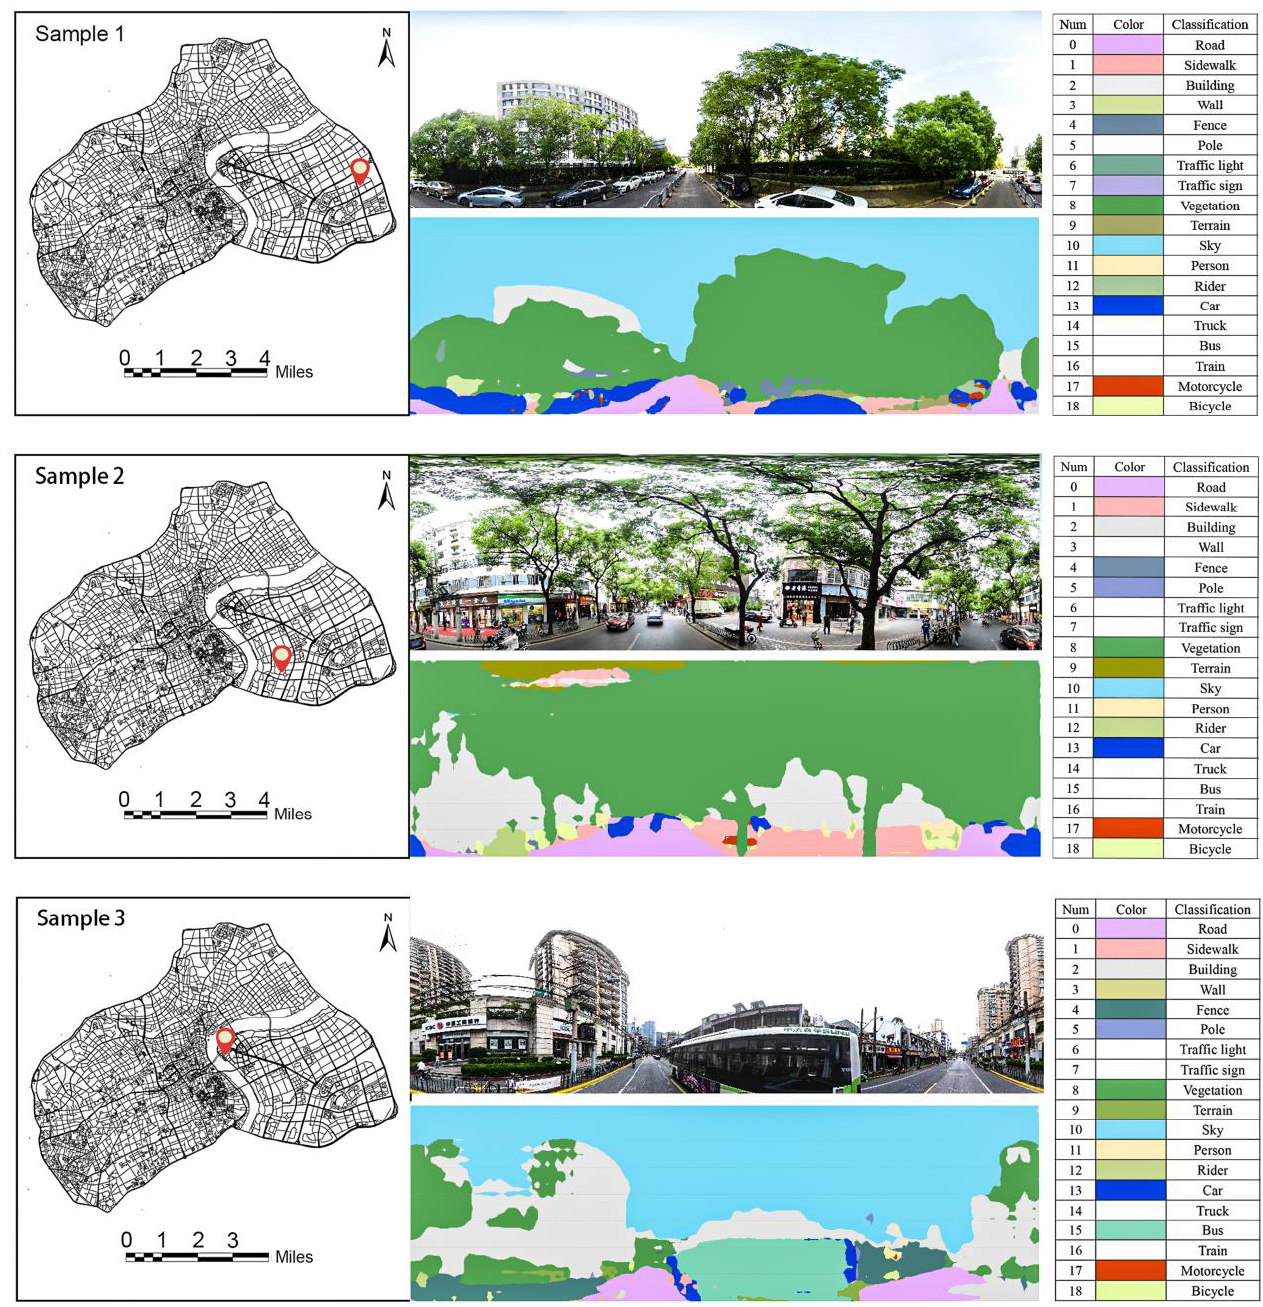
Figure 4. Segmentation demos by Deeplab.